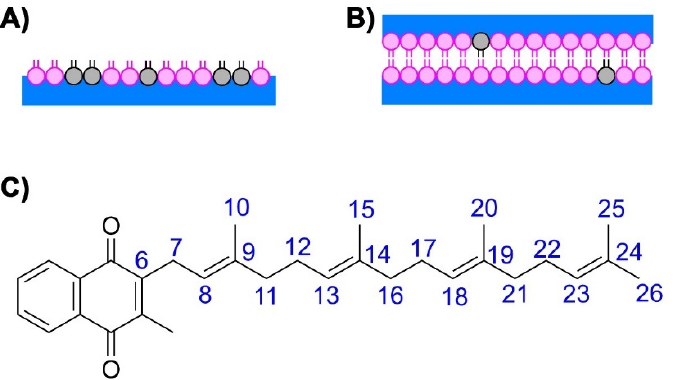
Figure 7. Cartoons of different model membrane systems as well as the numbering of carbons for computational studies. ( A ) Illustration of the monolayer system with a mix of phospholipid (pink) and MK (grey). ( B ) Illustration of a bilayer system with a molecule of MK in each of the phospholipid layer in the bilayer, ( C ) Labeling scheme of MK-1 through MK-4 (MK composed by n = [1–4] isoprenoid units) used in computational studies. The terminal carbon (CT) groups on MK-1 are labeled 10 and 11, the CT groups on MK-2 are labeled 15 and 16, the CT groups on MK-3 are labeled 20 and 21, the CT groups on MK-4 are 25 and 26.